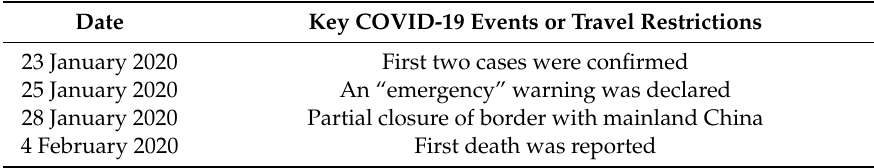
Table 1. Timelines of key COVID-19 events and social distancing rules in Hong